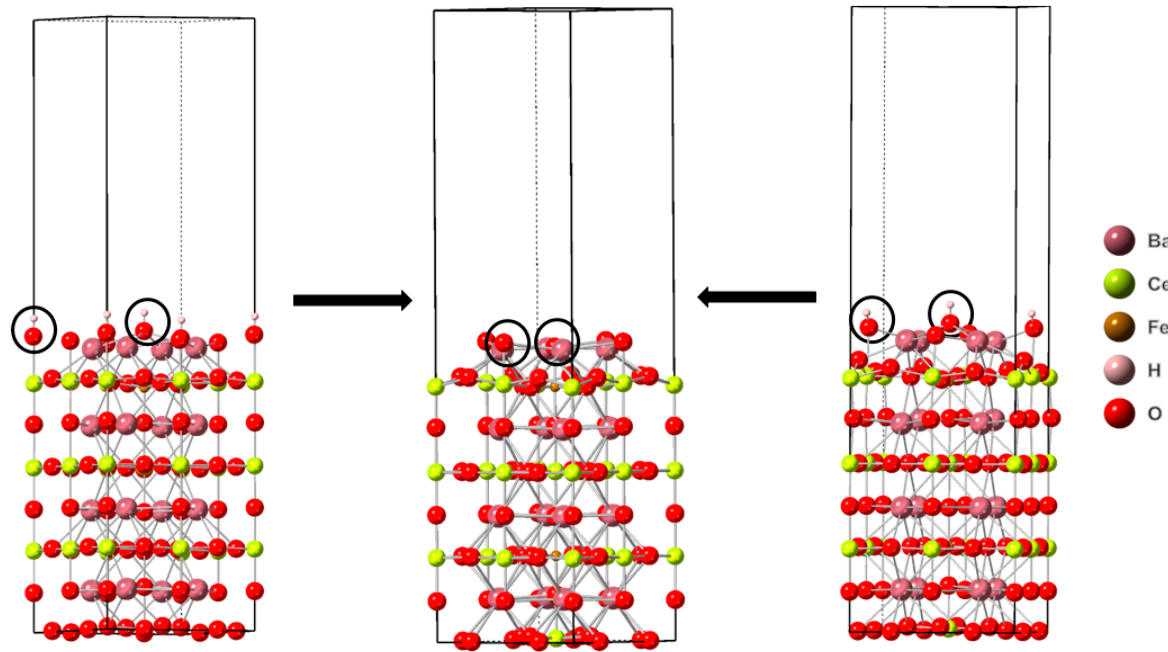
Figure 7. The reaction sites are indicated by black circles. The lefthand structure stoichiometry is Ba 16 Ce 14 Fe 2 H 2 O 48 . The righthand structure stoichiometry is Ba 16 Ce 14 Fe 2 H 2 O 47 . The center structure stoichiometry is Ba 16 Ce 14 Fe 2 O 47 . Images generated using CrystalMaker ® , CrystalMaker Software Ltd., (Oxford, England), (www.crystalmaker.com accessed on 26 December 2022).